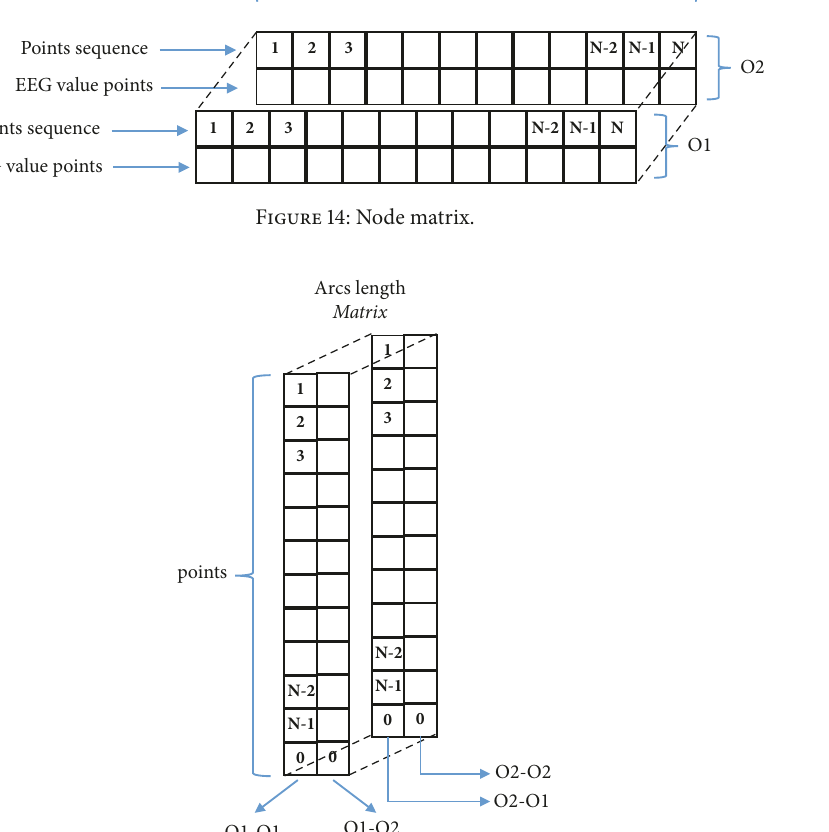
Figure 13: Signals segments O1 and O2.